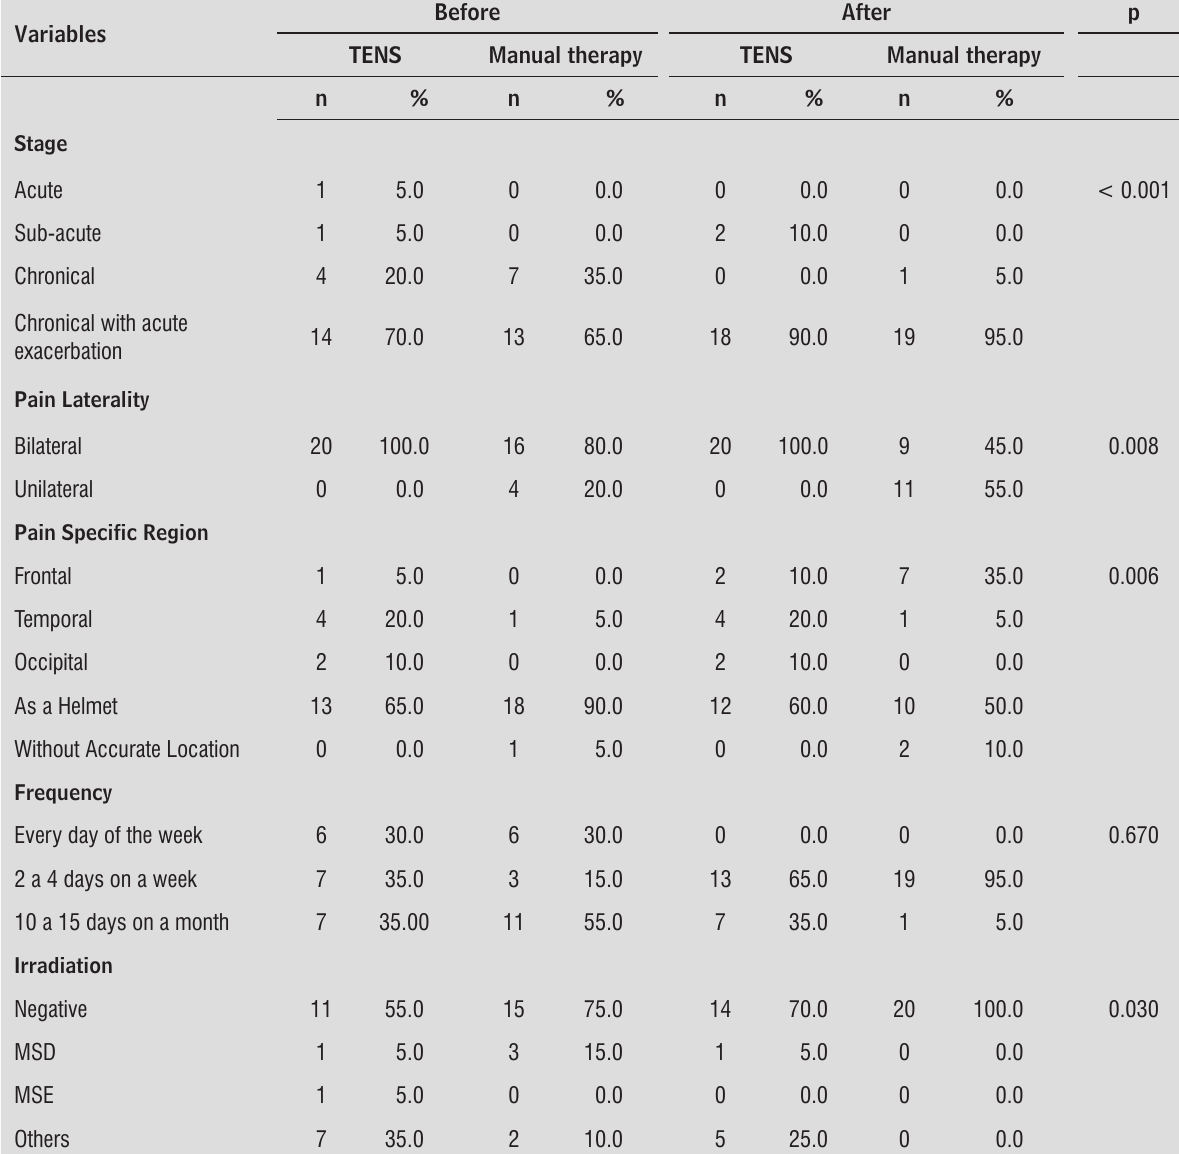
Table 4 - Comparison between TENS and Manual Therapy accordingly pain related clinical variables